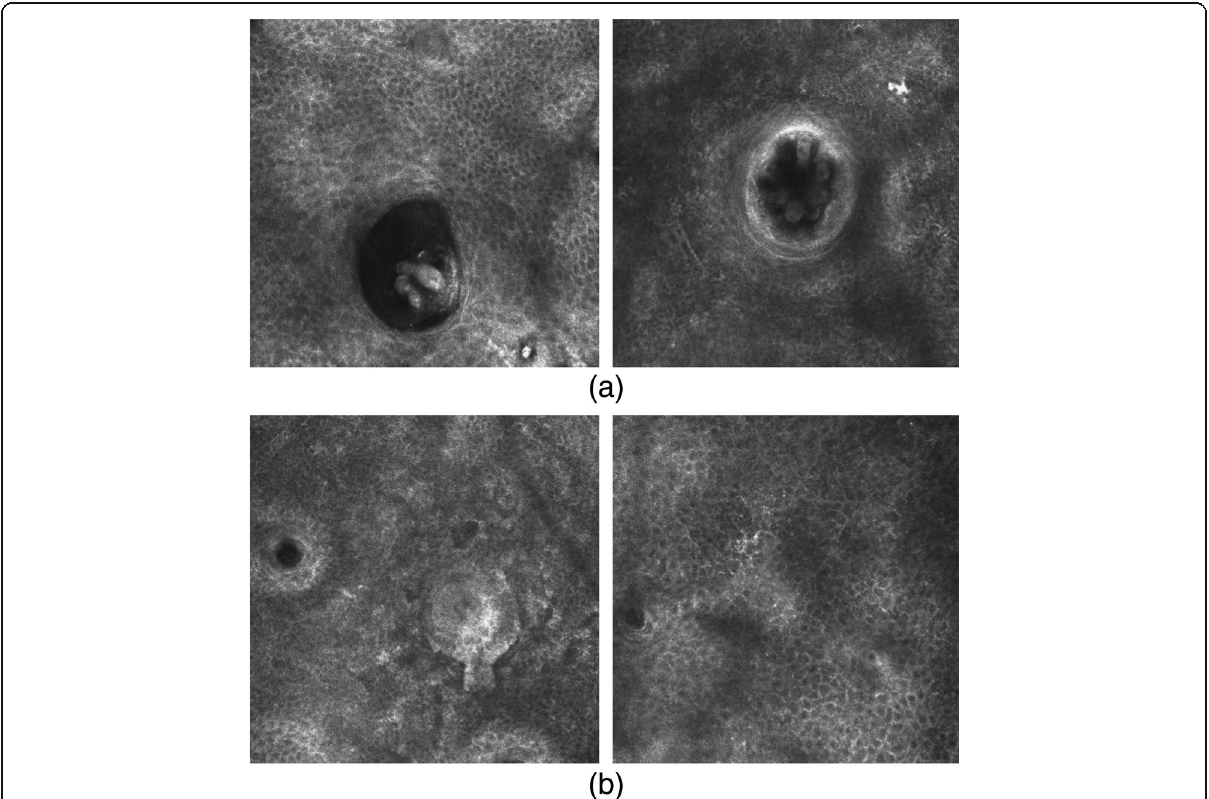
Fig. 4 The image of the seed data set a with demodicosis and b without demodicosis. Two kinds of labeled skin disease images are collected from the Xiangya Third Hospital. One is a laser scanning confocal microscope of demodicosis; the other is a laser scanning confocal microscope of no